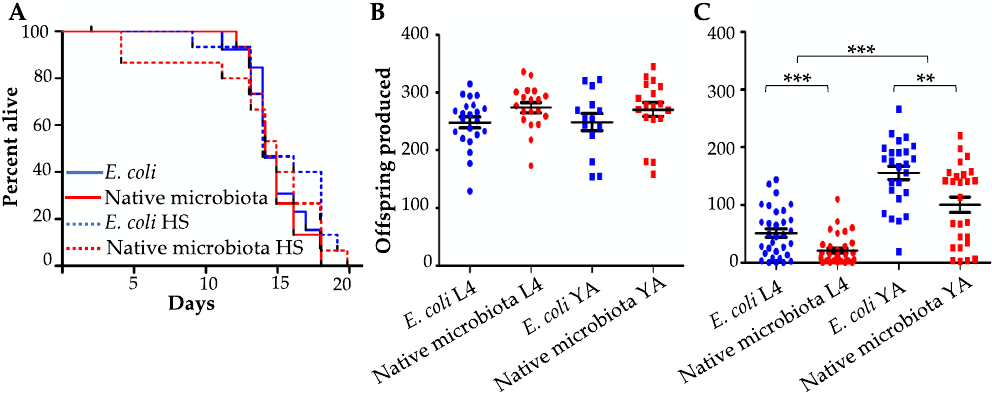
Figure 2. Growth on a complex microbiota reduces fecundity following heat stress. ( A ) Lifespan of worms with or without heat stress (HS). Data pooled across 2 experiments (20 °C, n = 13 – 15 worms per group per experiment; NS, Log rank test). ( B , C ) Fecundity of worms raised in compost microcosms, transferred to plates as L4 larvae or young adults (YA) and maintained at 20 °C ( B ), or heat-shocked at 31 °C for 6 h at the designated stage ( C ). Each dot represents the lifetime offspring produced by a single worm. Error bars represent ± standard error of the mean. Data pooled across 5 replicate experiments. ** p < 0.01, *** p < 0.001, t -test.